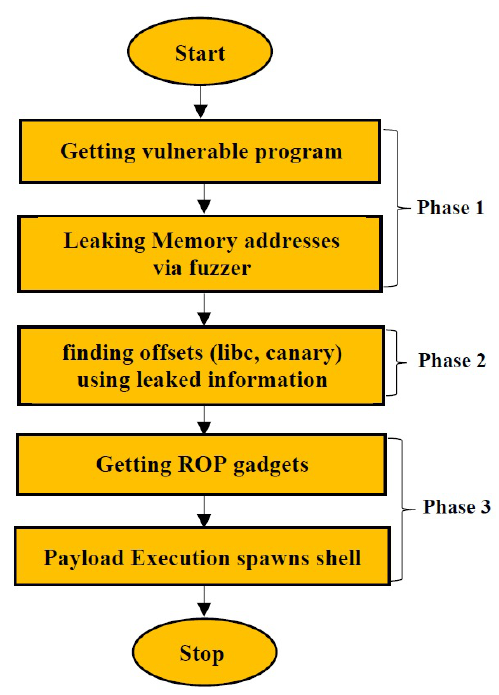
Figure 30. Bypassing Stack Canary.